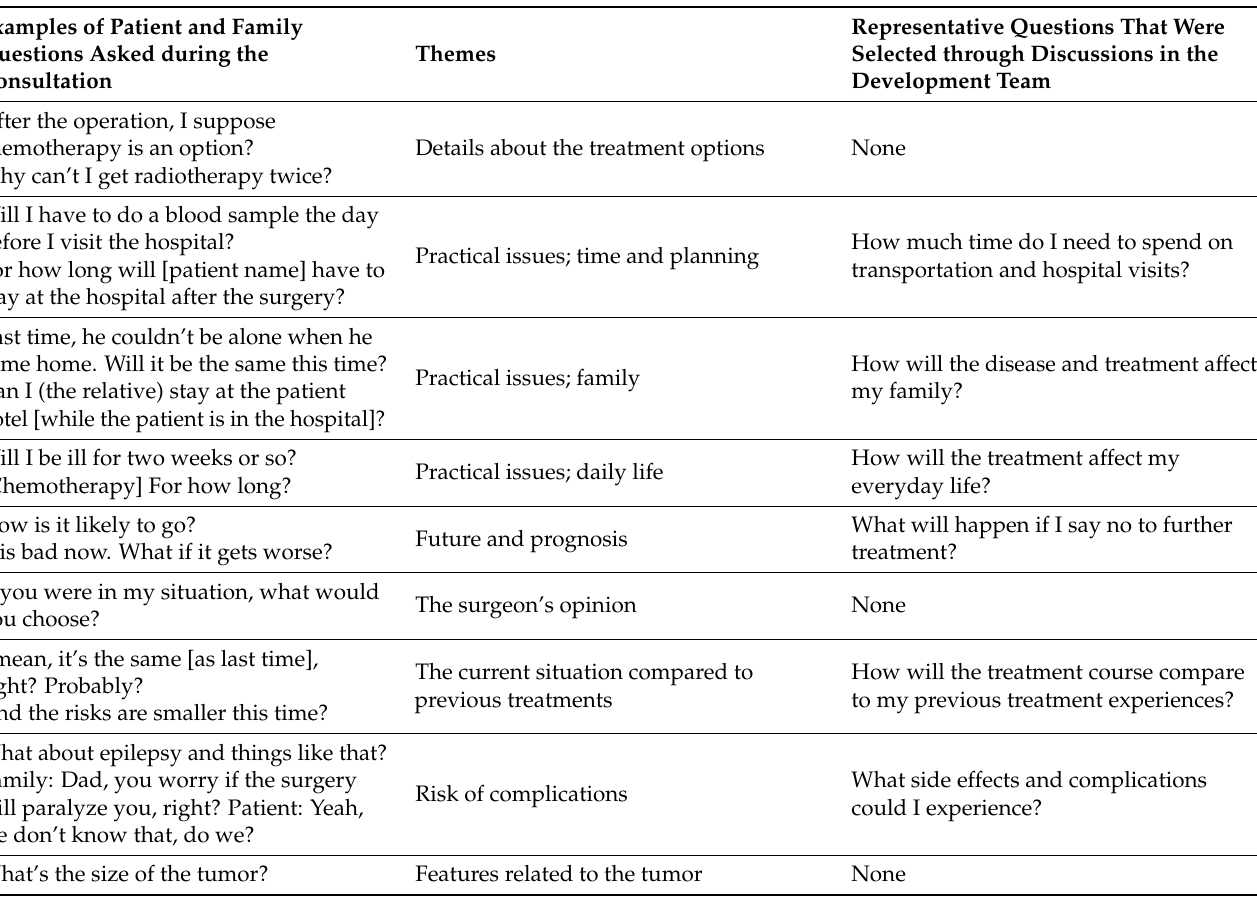
Table A1. The process of identifying questions for the preparation